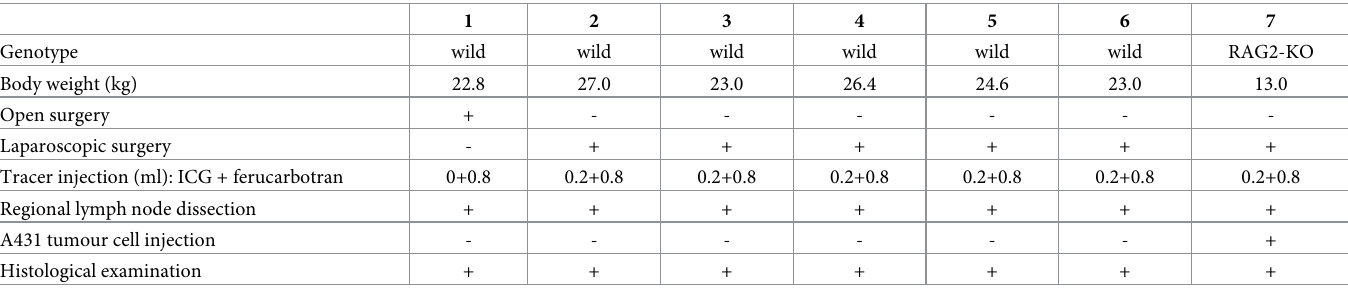
Table 1. All experimental data for